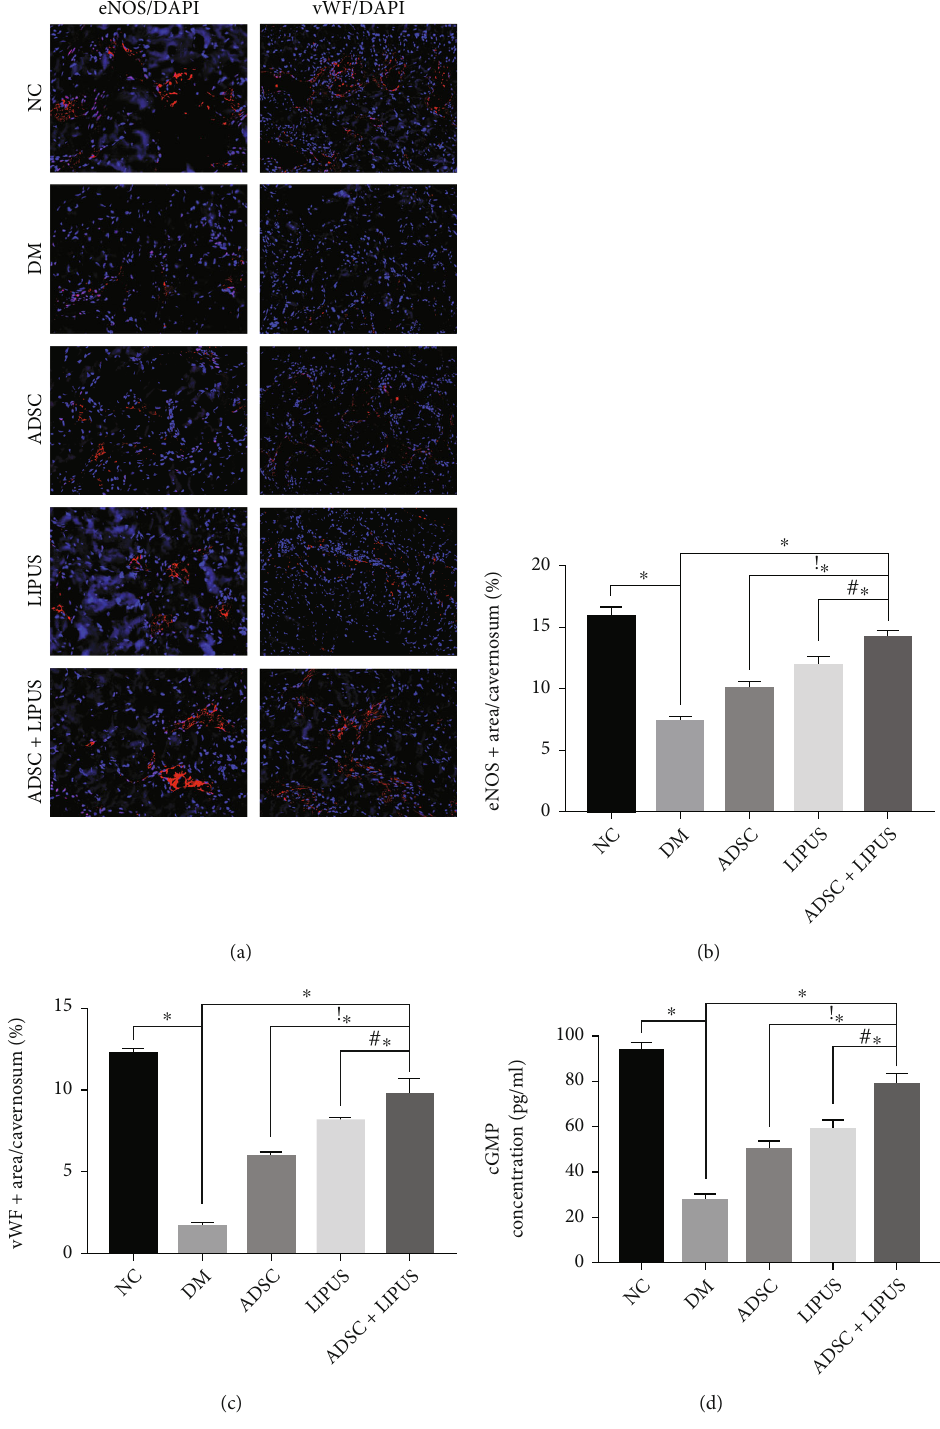
Figure 3: Endothelial content variations in the corpus cavernosum. (a) Representative immuno fl uorescence staining of eNOS (red) and vWF (red) in penile tissues from the NC, DM, ADSC, LIPUS, and ADSC+LIPUS groups. (b) Quantitative data of cavernous eNOS- positive endothelial cell content using ImageJ. (c) Quantitative data of cavernous vWF-positive endothelial cell content using ImageJ. (d) Cavernous cGMP levels in each group were assessed with ELISA. Data are presented as the mean ± standard deviation. ∗ p < 0 : 05 when comparing the NC group. ! ∗ p < 0 : 05 when comparing the ADSC group. # ∗ p < 0 : 05 when comparing the LIPUS